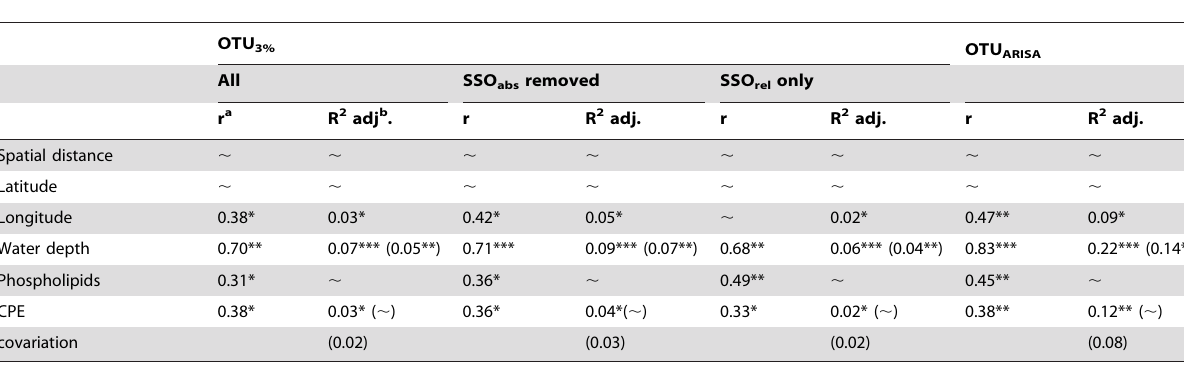
Table 1. Community response to spatial and environmental